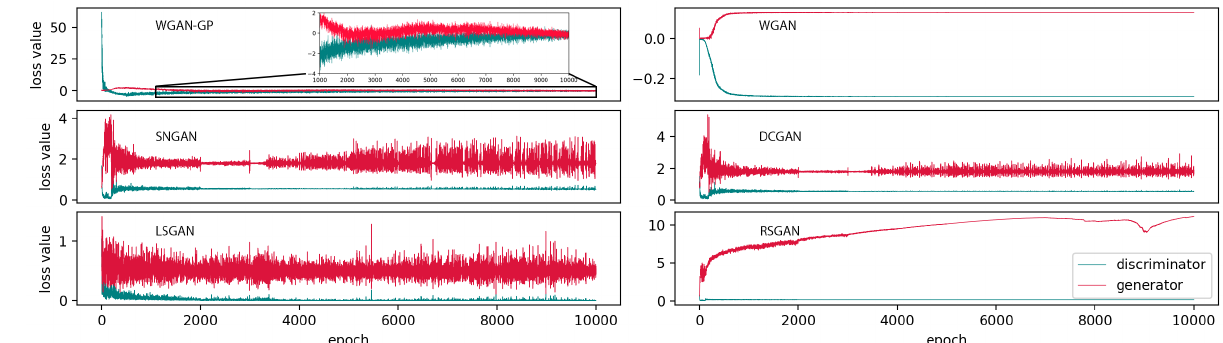
Figure 8. The generator and discriminator loss values for different GAN architectures.